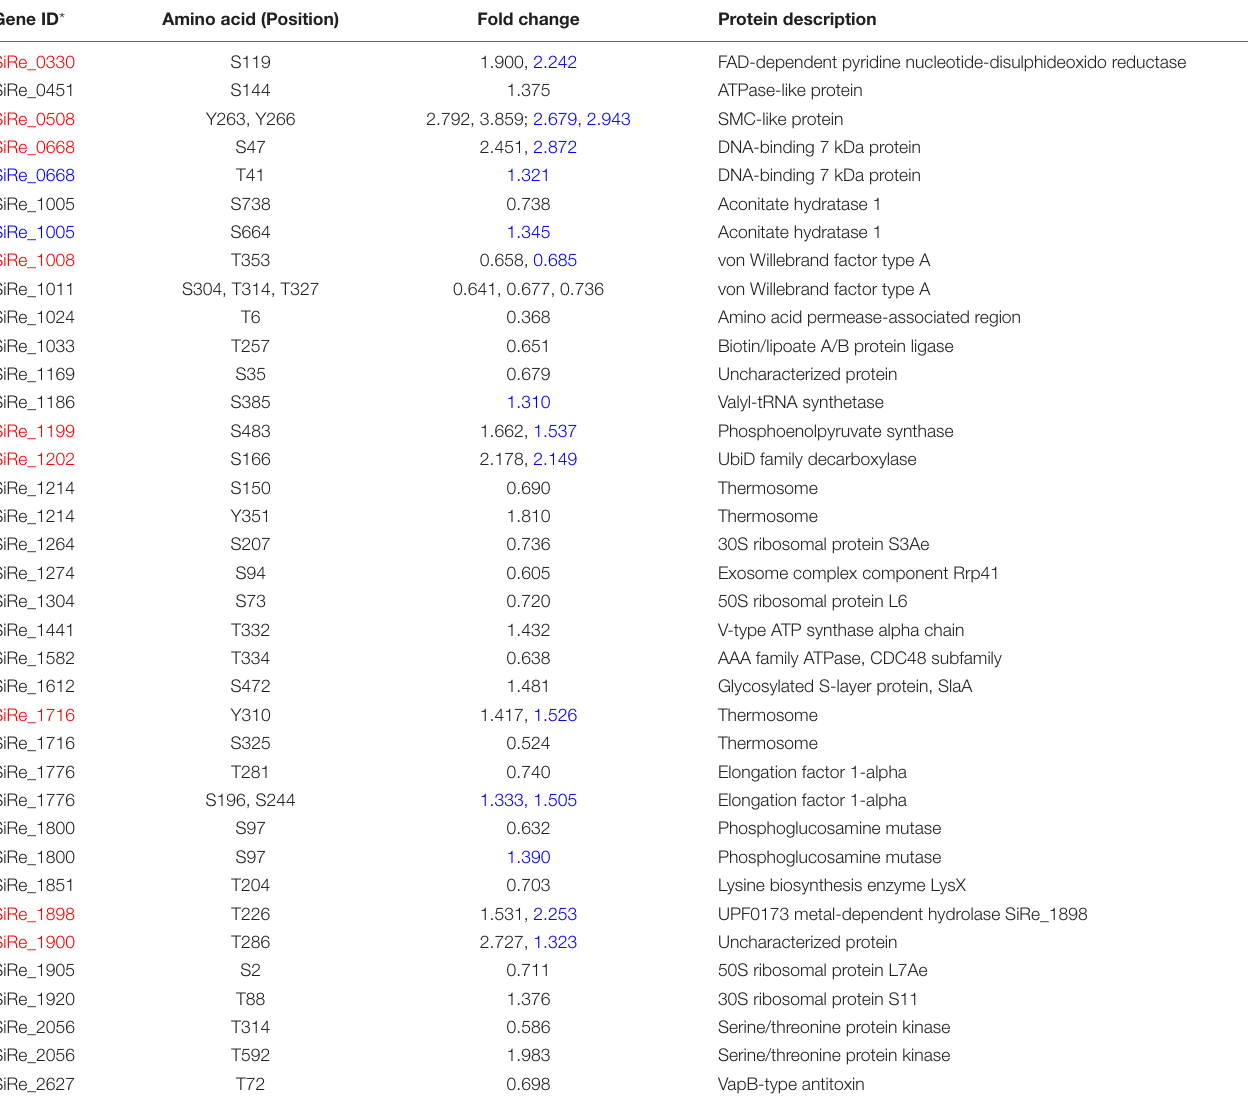
TABLE 2 | Differentially phosphorylated proteins in UV-E233S/E233S and/or UV- (cid:49) rio1 / (cid:49)